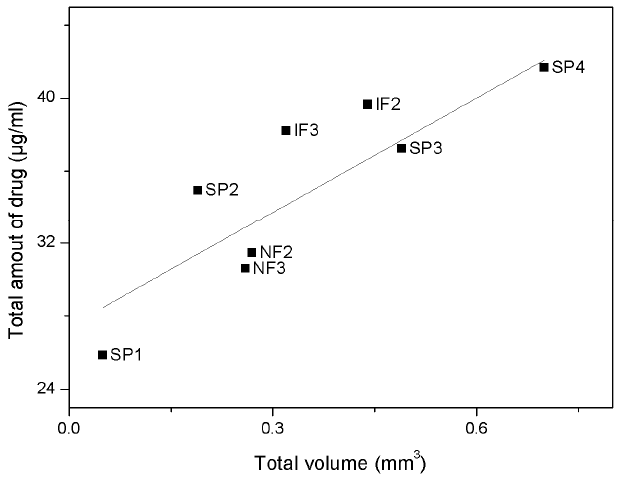
Figure 6. Total drug load within the pores versus the respective total volume for various nanoporous anodic alumina (NAA) structures. Linear regression for straight pores (SP) samples (dotted line).